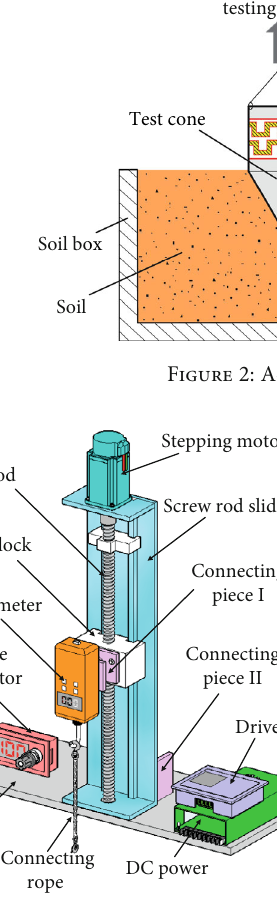
Figure 3: Electric traction testing